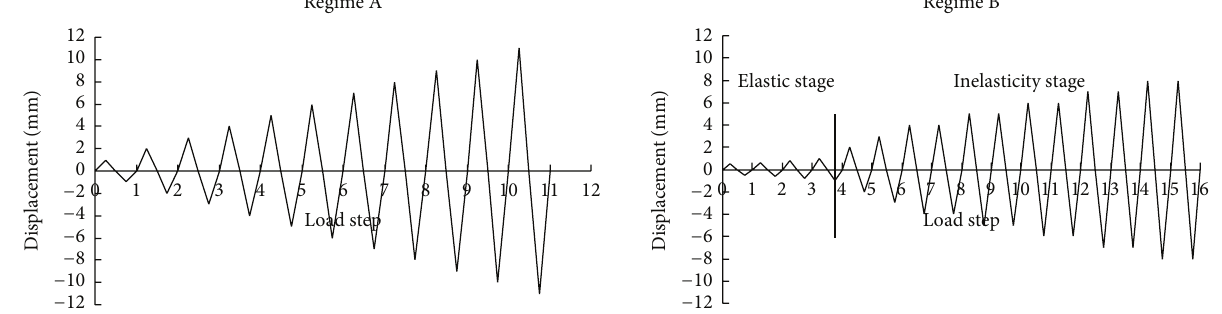
Figure 2: Reinforcement of specimens (dimensions in mm).